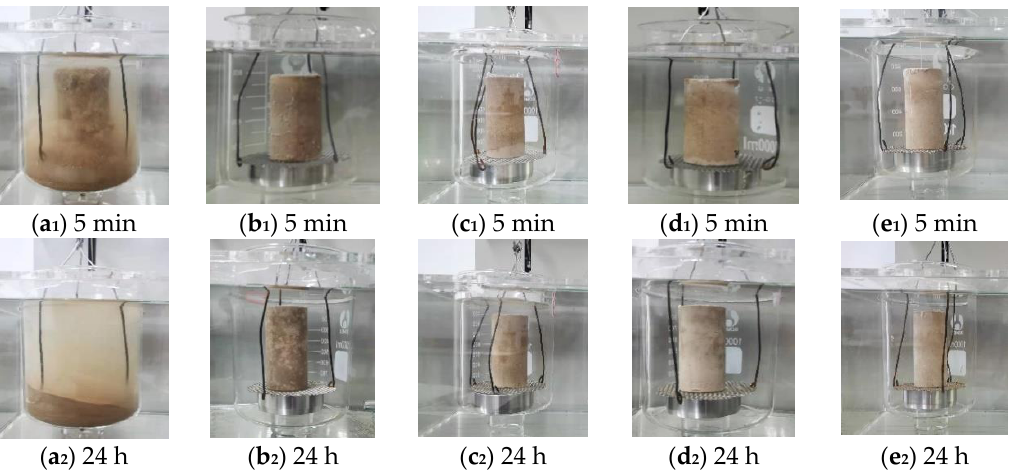
Figure 3. Water-resistance performance test (( a ): pure soil; ( b ): 0.03%; ( c ): 5%; ( d ): 10%; ( e ): 15%). The effect of water absorption with time on the water absorption rate of the specimens is shown in Figure 4. The water absorption rates of the specimens at 0.03%, 5%, 10%, and 15% CO 2 concentrations were 22.59%, 5.92%, 5.49%, and 5.37%, respectively, after 24 h of specimen water absorption. The water absorption rates of the specimens maintained at 5%, 10%, and 15% CO 2 concentrations were similar and decreased by 16.67%, 17.1%, and 17.22%, respectively, compared with those maintained at 0.03% CO 2 concentration. This indicates that the water absorption of the imitation site soil does not decrease linearly with the increase in the CO 2 concentration, and the water resistance of the imitation site soil can be improved by carbonization under 5% CO 2 concentration. Maintaining proper carbonation can rapidly improve the water resistance of the imitation site soil and prevent the imitation site soil from collapsing when it is washed by